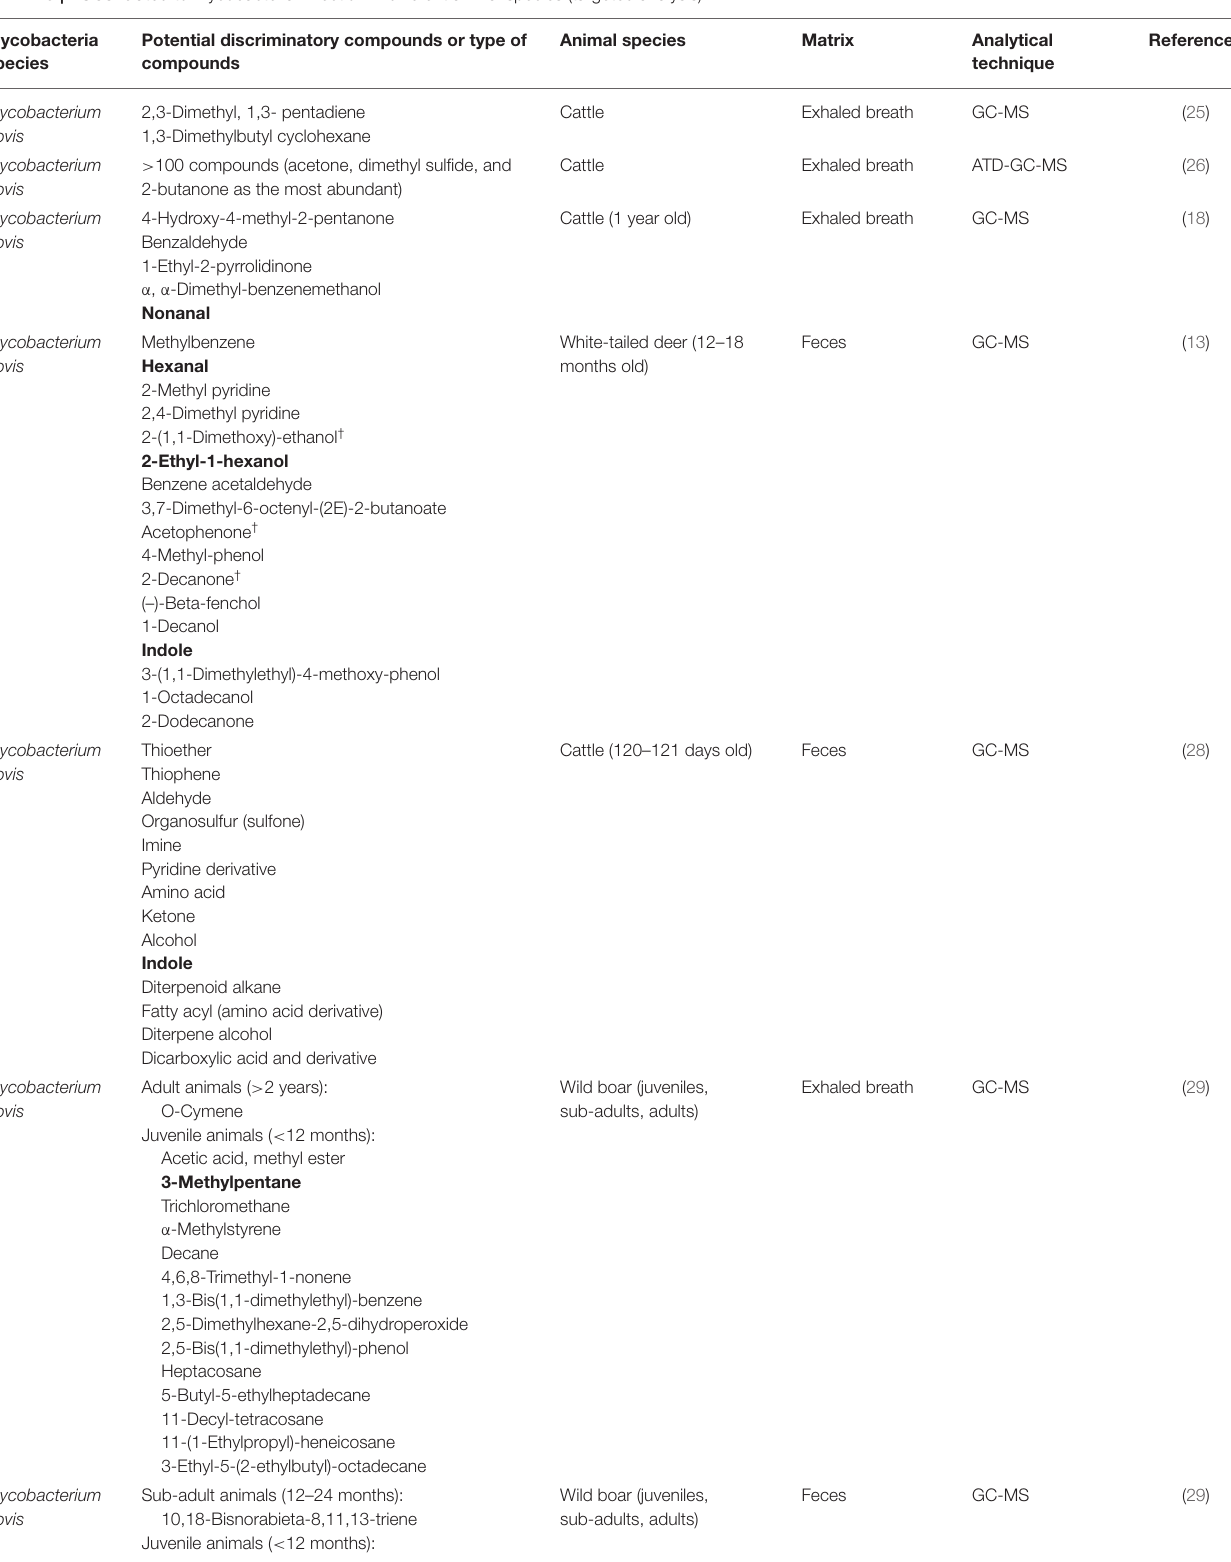
TABLE 3 | VOCs related to mycobacterial infection in different animal species (targeted analysis). Mycobacteria Potential discriminatory compounds or type of species compounds